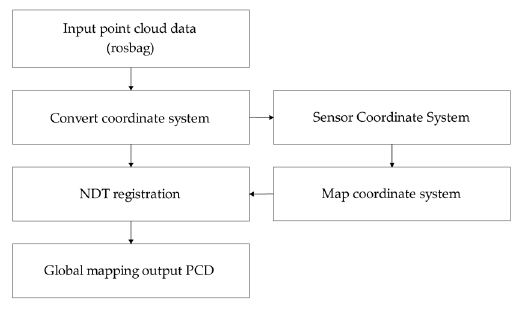
Figure 3. The flow of the NDT registration algorithm.